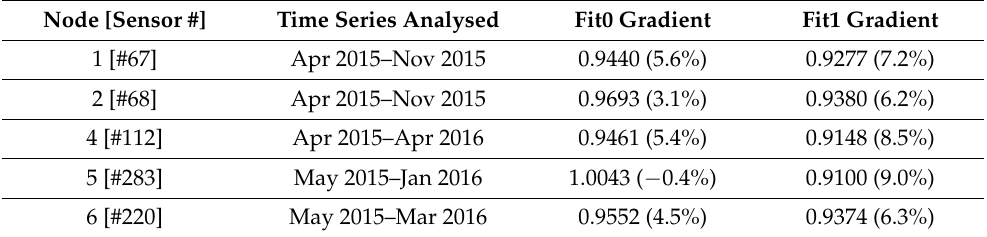
Table 1. Paired sensor data records, fit gradients, and the equivalent percentage uncertainty (in parenthesis). The type ft0 corresponds to a forced zero intercept linear regression, and ft1 corre- sponds to an unrestrained intercept linear regression.